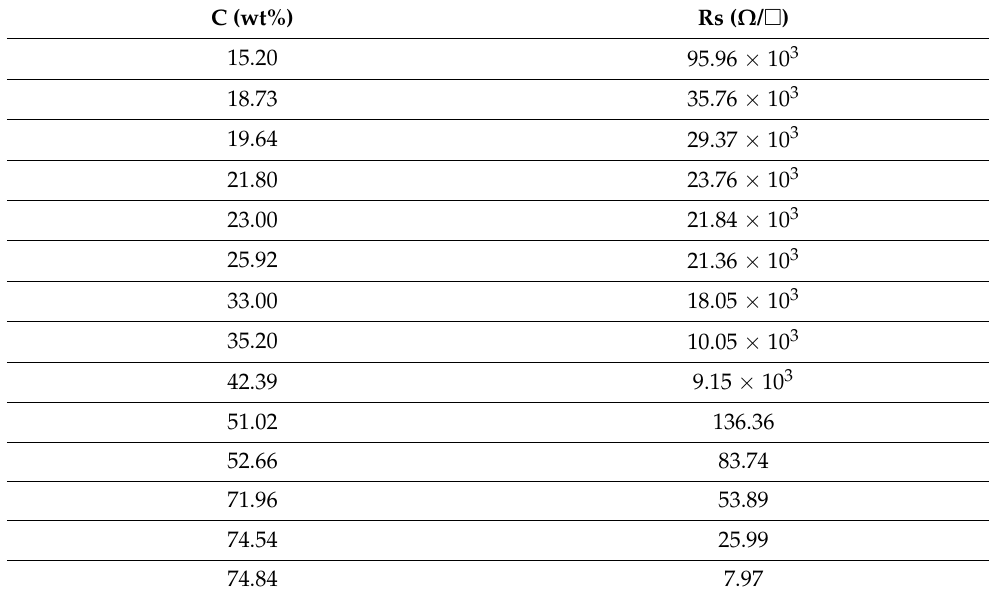
Figure 2. ( A ) Sheet resistance of graphite-based cotton at different concentration of graphite. ( B ) Plot between natural logarithm of sheet resistance and natural logarithm of concentration. Table 1. Sheet resistance values of the conductive cotton fabrics at different concentration of